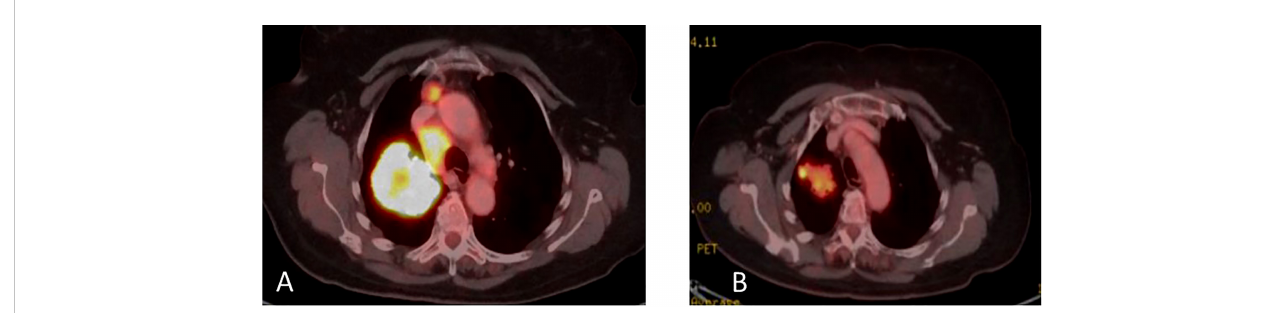
FIGURE 4 (A) Coronal PET-CT scan, from September 2017, show a large right lung mass with increased uptake of FDG-18. There is also ipsilateral hilar and mediastinal lymphadenopathy with positive PET uptake, contributing to classi fi cation as unresectable, stage 3B NSCLC. (B) January 2018, following